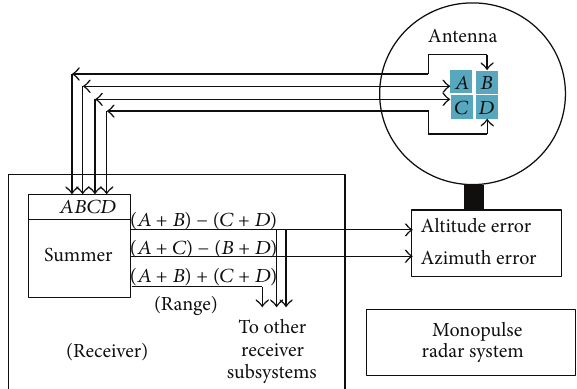
Figure 1: Monopulse radar system.